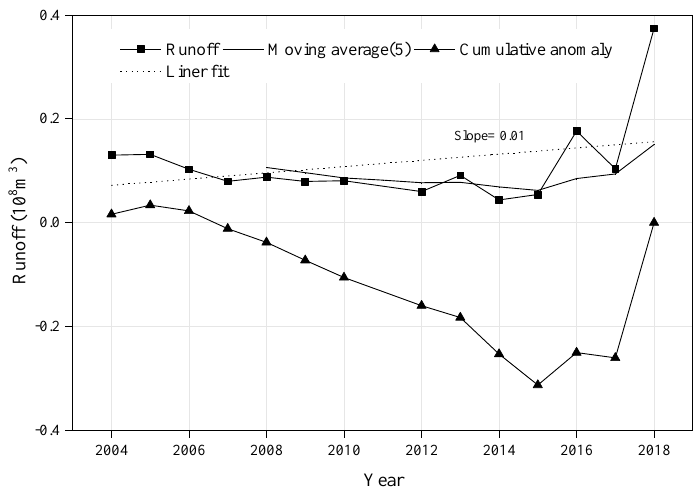
Figure 4. Runoff changing trend in the Dongdaqiao station from 2004 to 2018.